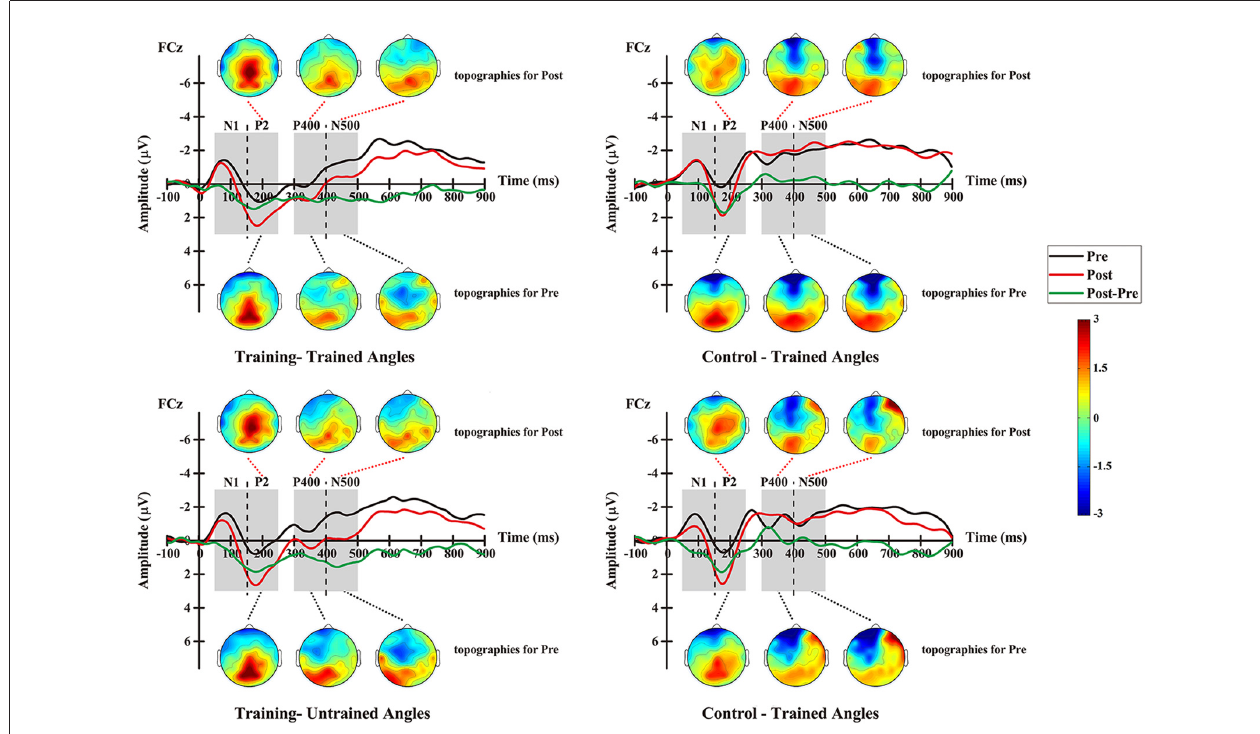
FIGURE 7 | Grand-averaged ERPs elicited by auditory stimuli at electrode FCz and topographic maps at pre- and post-test for the training group (left column) and the control group (right column), and shown separately for trained angles (upper row) and untrained angles (lower row).